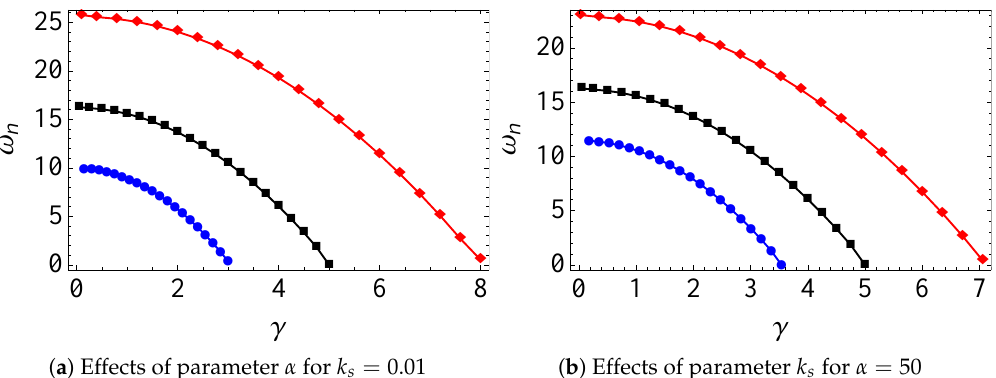
Figure 9. The natural frequency for different α and k s , with ξ 1 = 0.5, p = 0.04 fixed. ( a ) from top to bottom α = 80,50,30; ( b ) from top to bottom k s = 0.02,0.01,0.005.